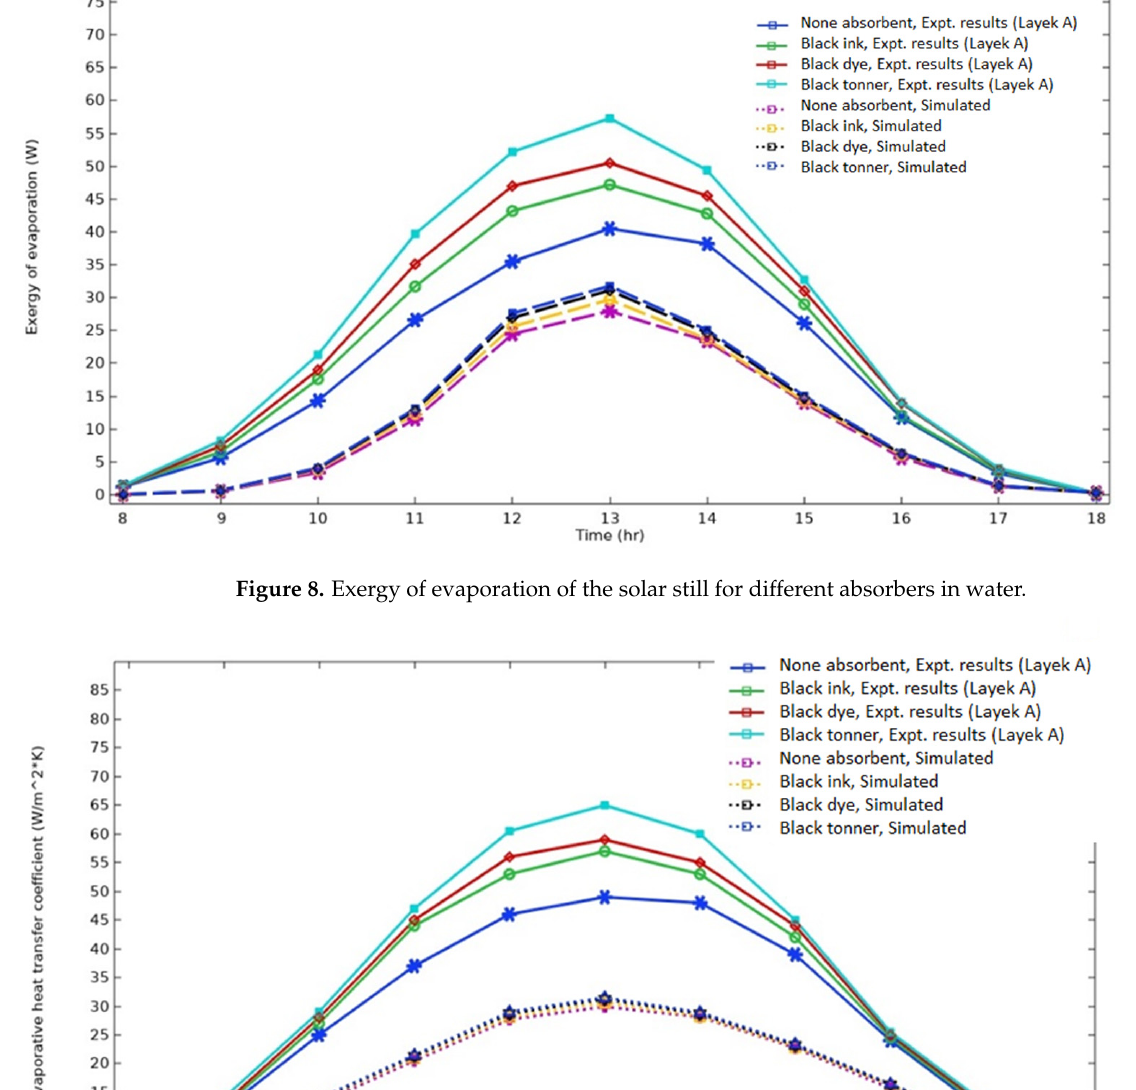
Figure 9. Evaporative heat transfer coefficient (h_ew) for various absorbing materials in water.